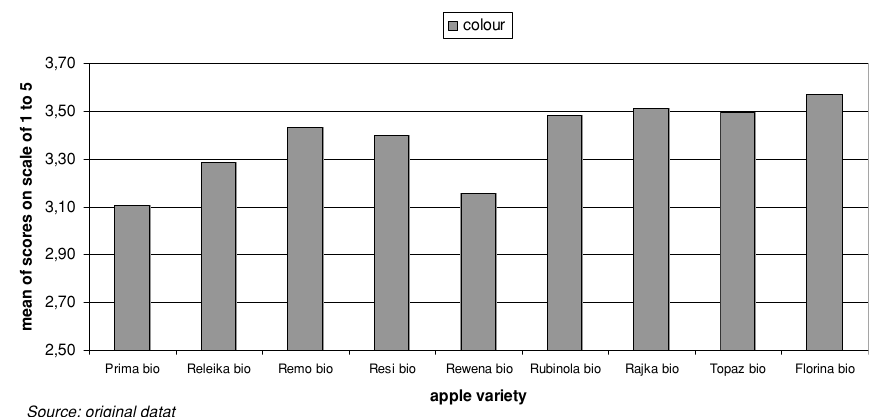
Figure 1: Mean ratings of varieties according to their colour